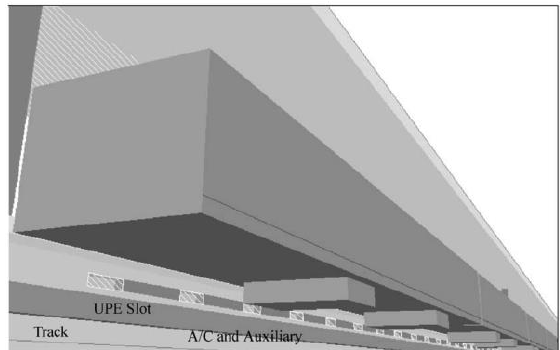
Figure 4. Local detail layout of present underground station [29].